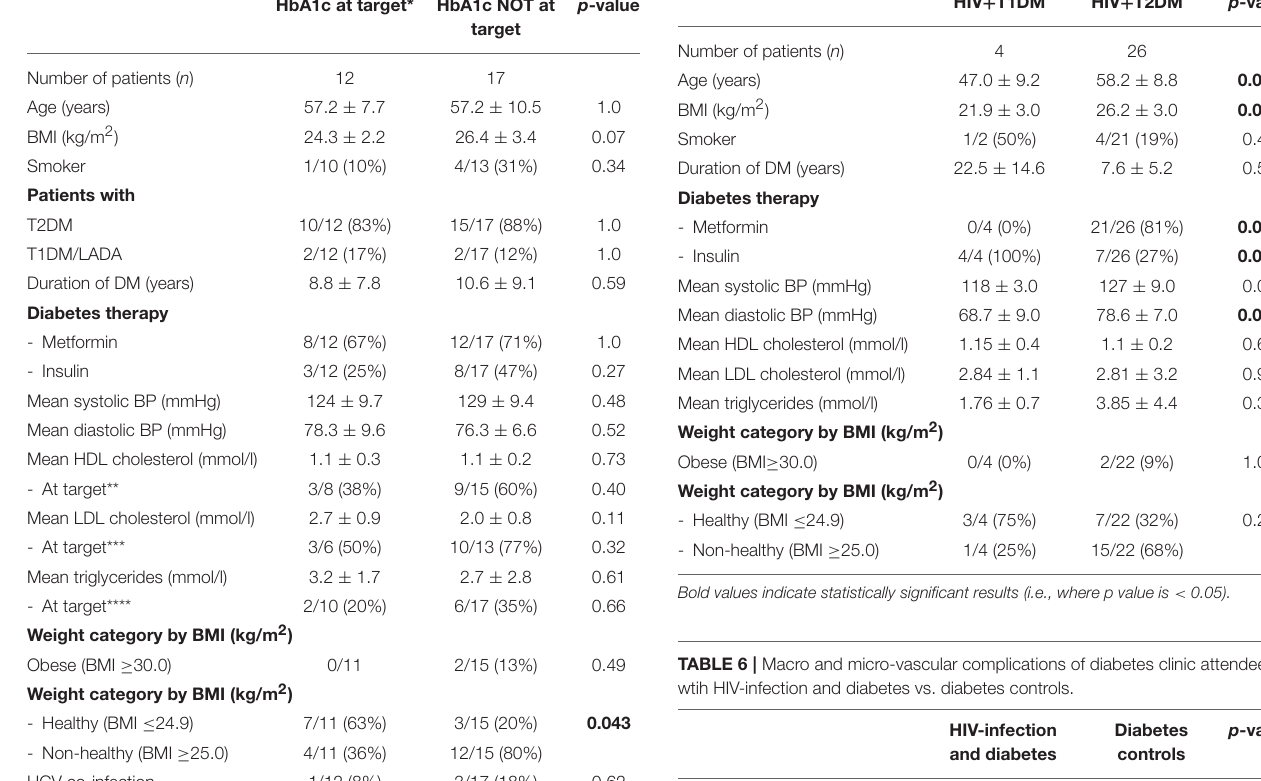
TABLE 5 | Subgroup analysis of diabetes clinic attendees with HIV-infection and TABLE 4 | Subgroup analysis of diabetes clinic attendees with HIV-infection and T1DM vs. T2DM. diabetes based on whether they met their HbA1c target*. HbA1c at target* HbA1c NOT at target